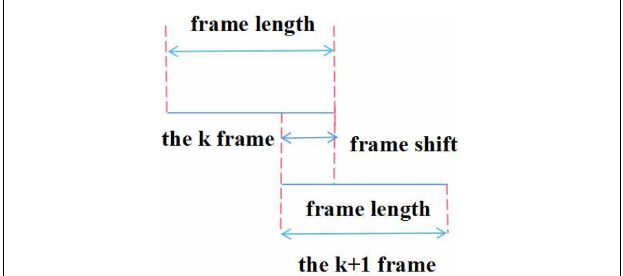
FIGURE 3 | Windowing of speech signals.